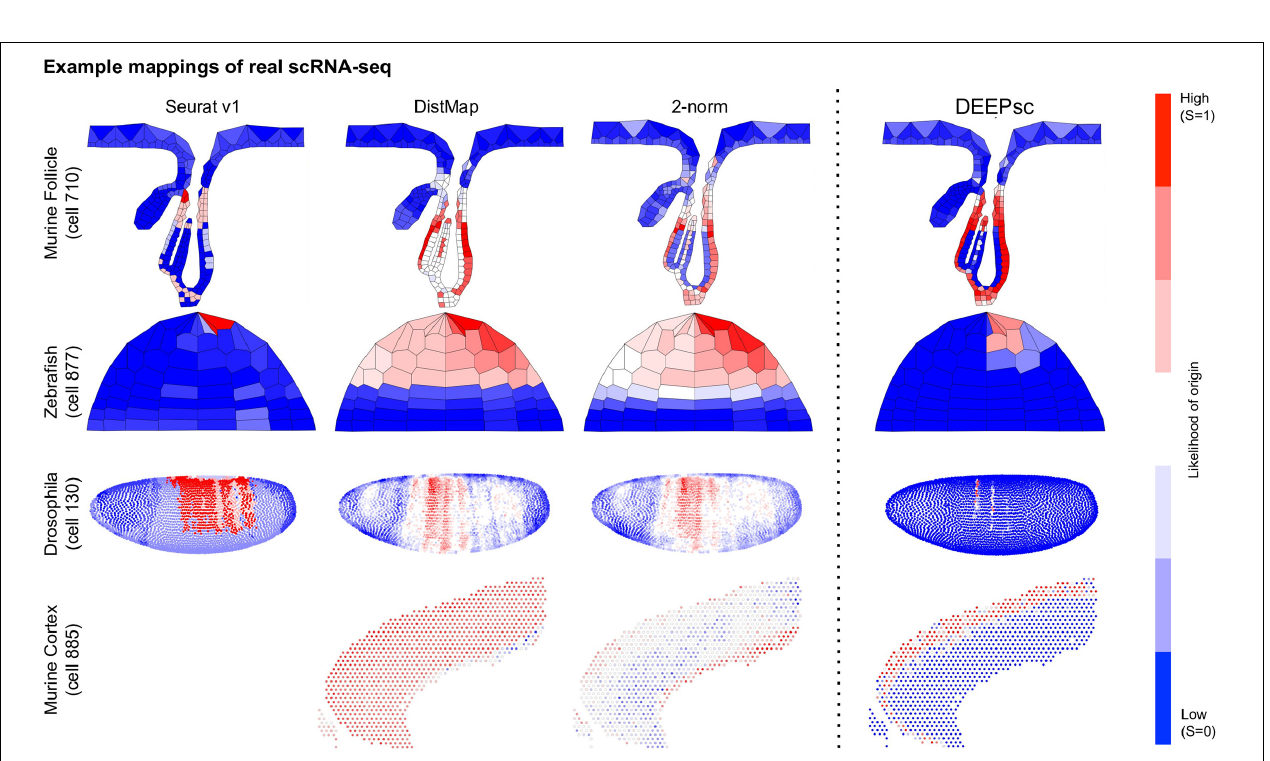
FIGURE 7 | Example mappings of real single cells produced by various existing methods on four different biological systems, with DEEPsc mappings for comparison. The input cell for the murine follicle system is cell 710 from the Joost dataset. For the Zebrafish system (for which Seurat v1 was introduced), the input cell is cell 877 from the scRNA-seq dataset (Satija et al., 2015). For Drosophila (for which DistMap was introduced), the input cell is cell 130 from the scRNA-seq dataset (Karaiskos et al., 2017). For the murine frontal cortex, the input cell is cell 885 from the Allen reference dataset (Tasic et al., 2016).